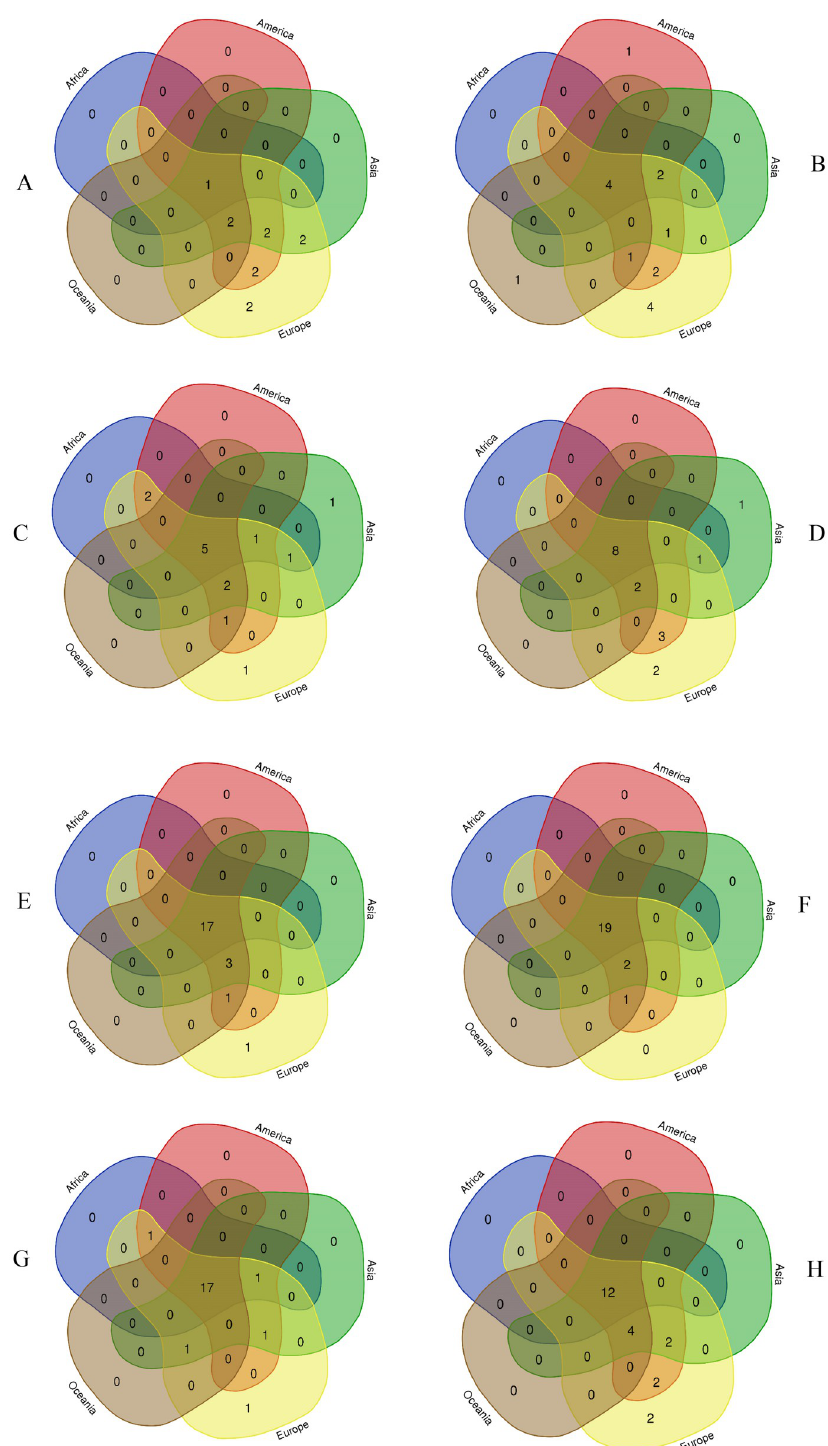
Fig 5. Venn diagram representing the incidence of significant point mutations at RBD and S1/S2 junction at spike protein of circulating SARS-CoV-2 in six continents during (A) January to June, 2020 (B) July to December, 2020 (C) January to June, 2021 and (D) July to December, 2021. The frequency of collective point mutations and common point mutations at S protein among the six continents increased significantly after June, 2020. Venn diagram representing the incidence of significant point mutations at nucleocapsid and nonstructural protein among circulating SARS-CoV-